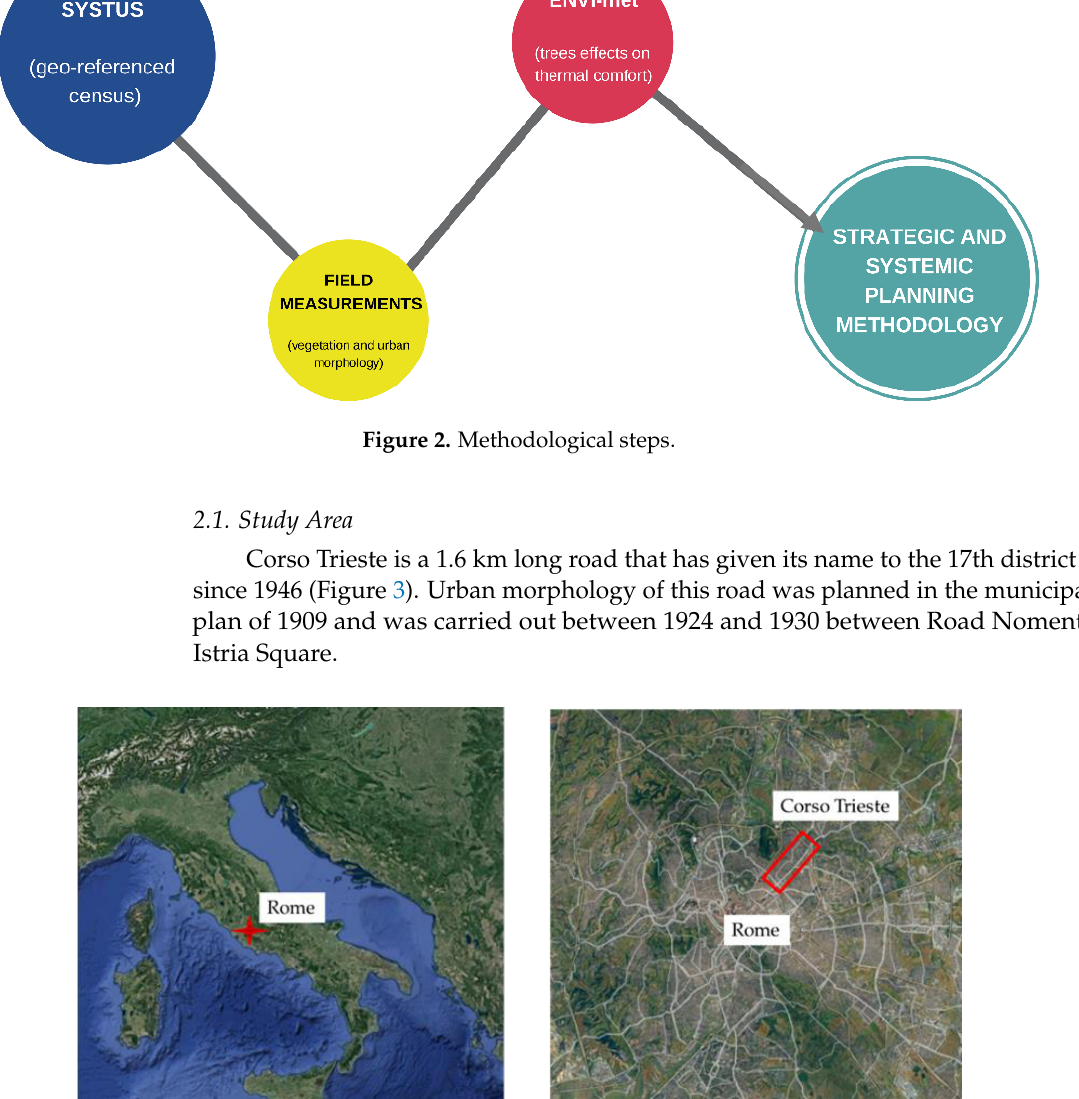
Figure 4. Corso Trieste in Rome (Italy). Left: 1945 satellite image from Google Earth and a 1933 historical photo (https://www.romasparita.eu/foto-roma-sparita/70111/corso-trieste-2, accessed on 31 March 2021). Right: Current satellite images and pictures. Attorre et al. [21] documented that in the 1955 census of Rome's green areas, which reported about 47,000 trees divided into 29 species, Pinus pinea L. was the most widely used with about 28% of the total. Specifically, the extensive use of this species occurred during the Fascist period. In fact, Pinus pinea L., considered to be the most beautiful tree in Italy, was the symbol of the regime's cultural links with the Roman Empire. After the